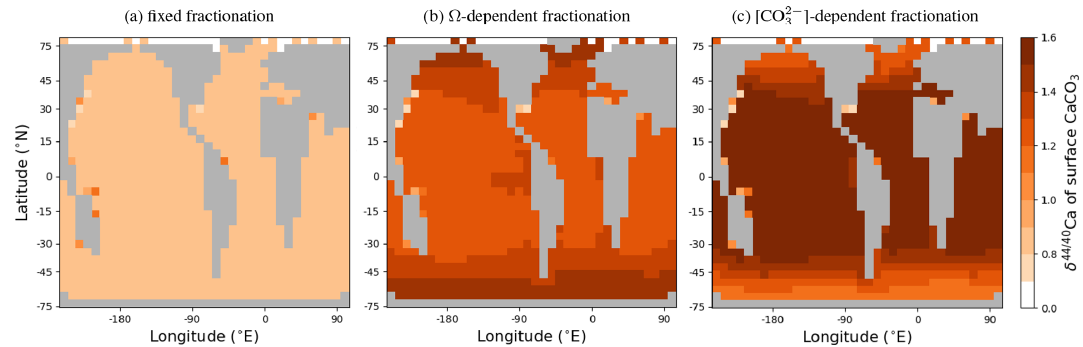
Figure C2. The δ 44 / 40 Ca of CaCO 3 in the top layer of marine sediments in simulations with different Ca isotope fractionation schemes: (a) fixed fractionation, (b, c) fractionation dependent on local conditions.